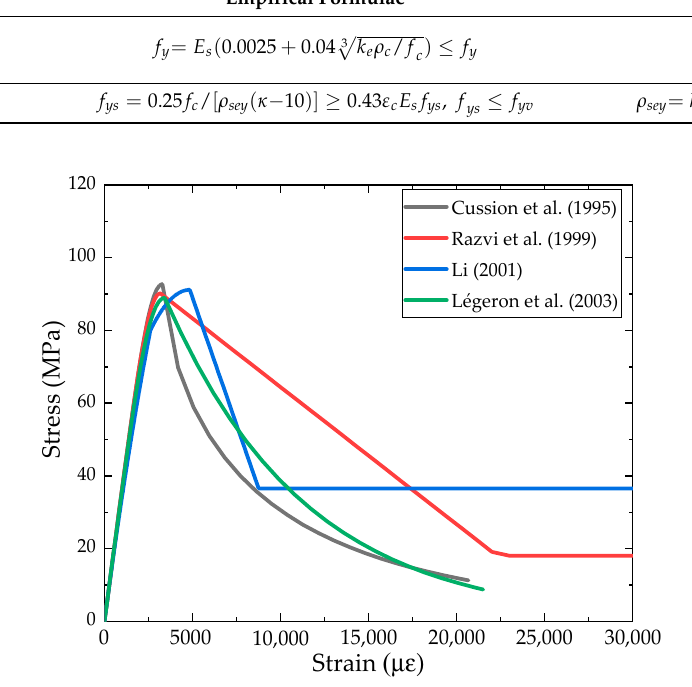
Figure 1. Comparison of the main models ( 𝑓 (cid:3030) = 80 MPa) [9,15,20,21].